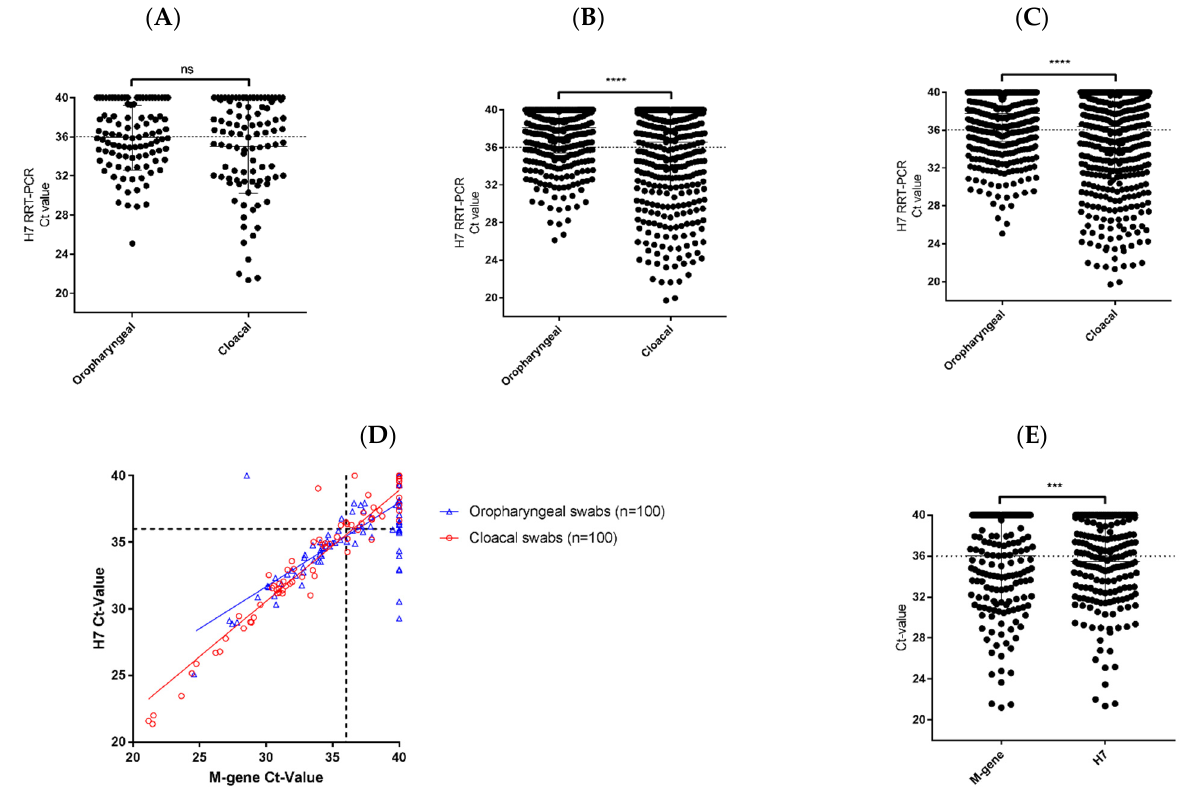
Figure 3. H7N7 high pathogenicity avian influenza virus (HPAIV) is shed predominantly via the cloacal route. Oropharyngeal (OP) and cloacal (C) swabs were tested by H7 RRT-PCR to determine the level of viral RNA present in the samples, as represented by the Ct value. The OP and C swab H7 RNA levels from ( A ) Sample Set 2 (N = 100, per swab type), ( B ) Sample Set 3 (N = 540, per swab type) and ( C ) all positive swab samples from Sample Sets 2 and 3 (N = 640, per swab type) were compared. ( D ) OP and C swabs in Sample Set 2 (N = 100, per swab type) were tested by M-gene and H7 RRT-PCRs and the correlation of the Ct values between assays was assessed using linear regression analysis or ( E ) direct comparison (N = 200, per assay). The Ct values were compared between OP and C swabs, or different RRT-PCR assays, using a Paired T-test for all samples. ns, not significant p > 0.05, *** p < 0.001 and **** p < 0.0001.